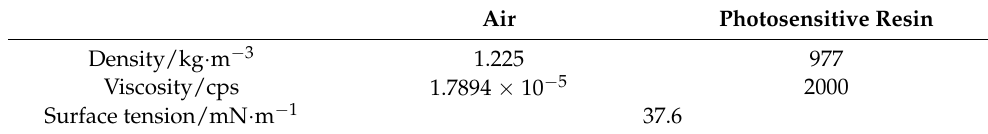
Table 2. Material properties.